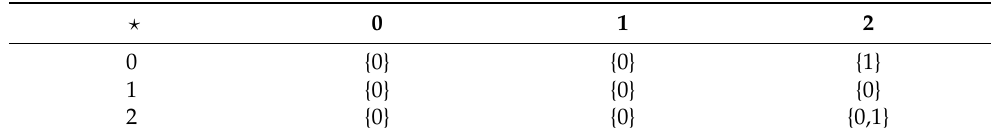
Table 15. The binary hypergroupoid ( C , (cid:63)